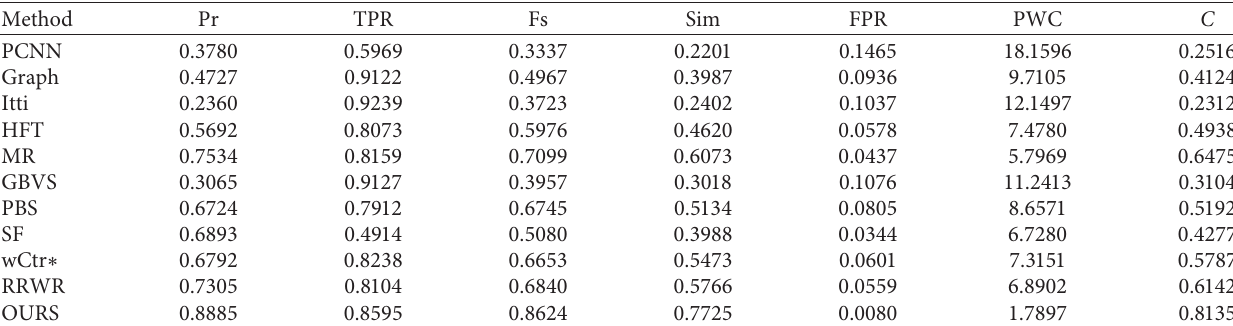
Table 1: Quantitative average performance